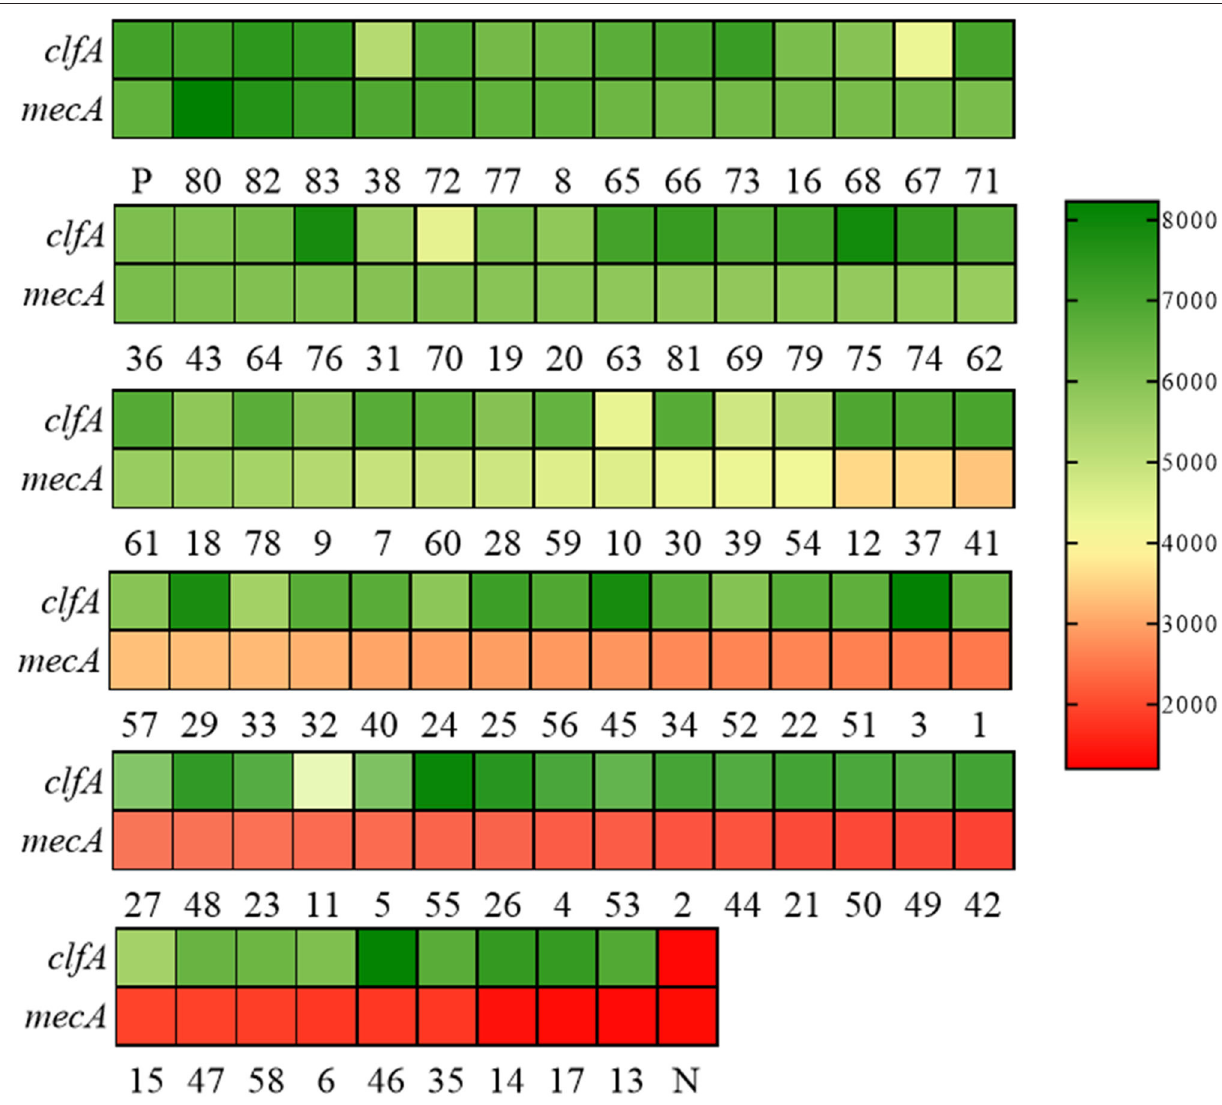
FIGURE 5 | RAA-Cas12a detection system for MRSA in 83 clinical samples. Green indicates that the gene detected in the sample is positive, and the shade of the color is positively correlated with the fluorescence value. Red indicates that the gene tested in the sample is negative, and the depth of red is negatively correlated with the fluorescence value. Positive control (P) and negative control (N). Both clfA and mecA tests are positive, indicating that the sample is